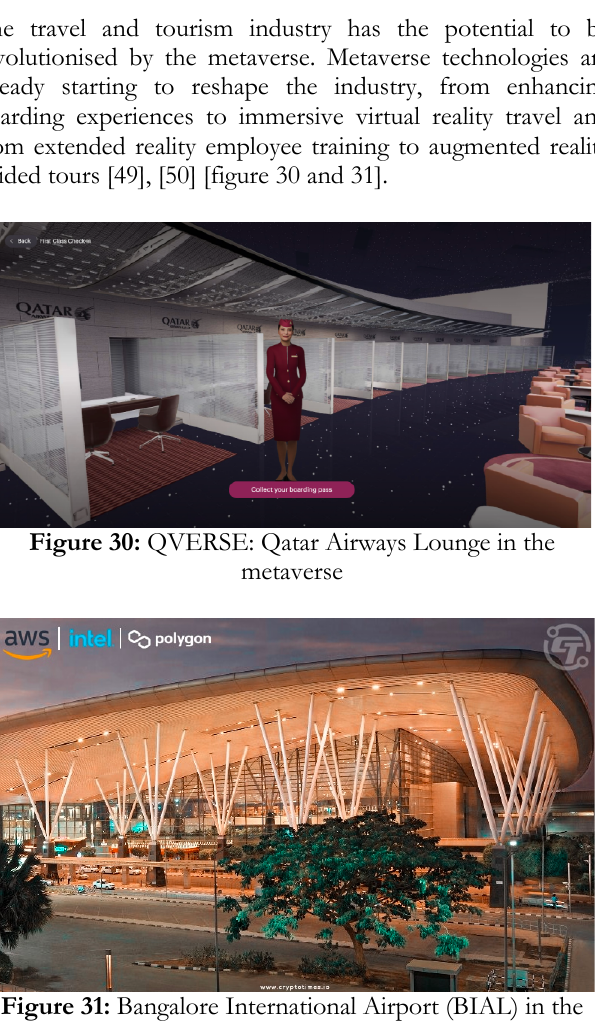
Figure 29: Islamabad United Pakistan Super League Cricket Stadium in Decentraland Metaverse Travelling and Tourism in the Metaverse